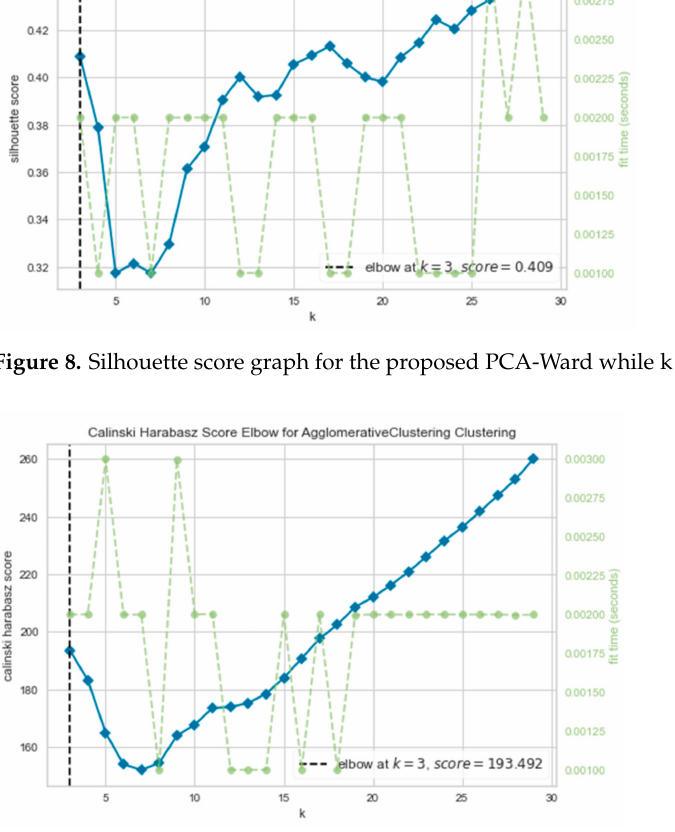
Figure 9. Calinski–Harabasz score graph for the proposed PCA-Ward while k = 3.